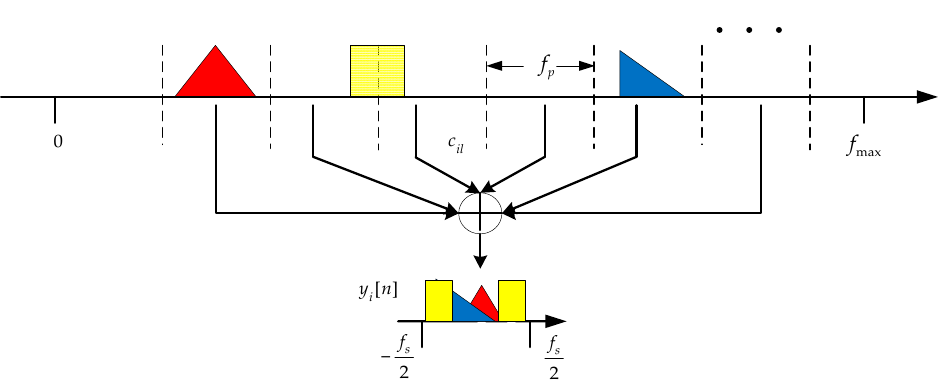
Figure 2. Abbreviated drawing of spectrum slices flitting.